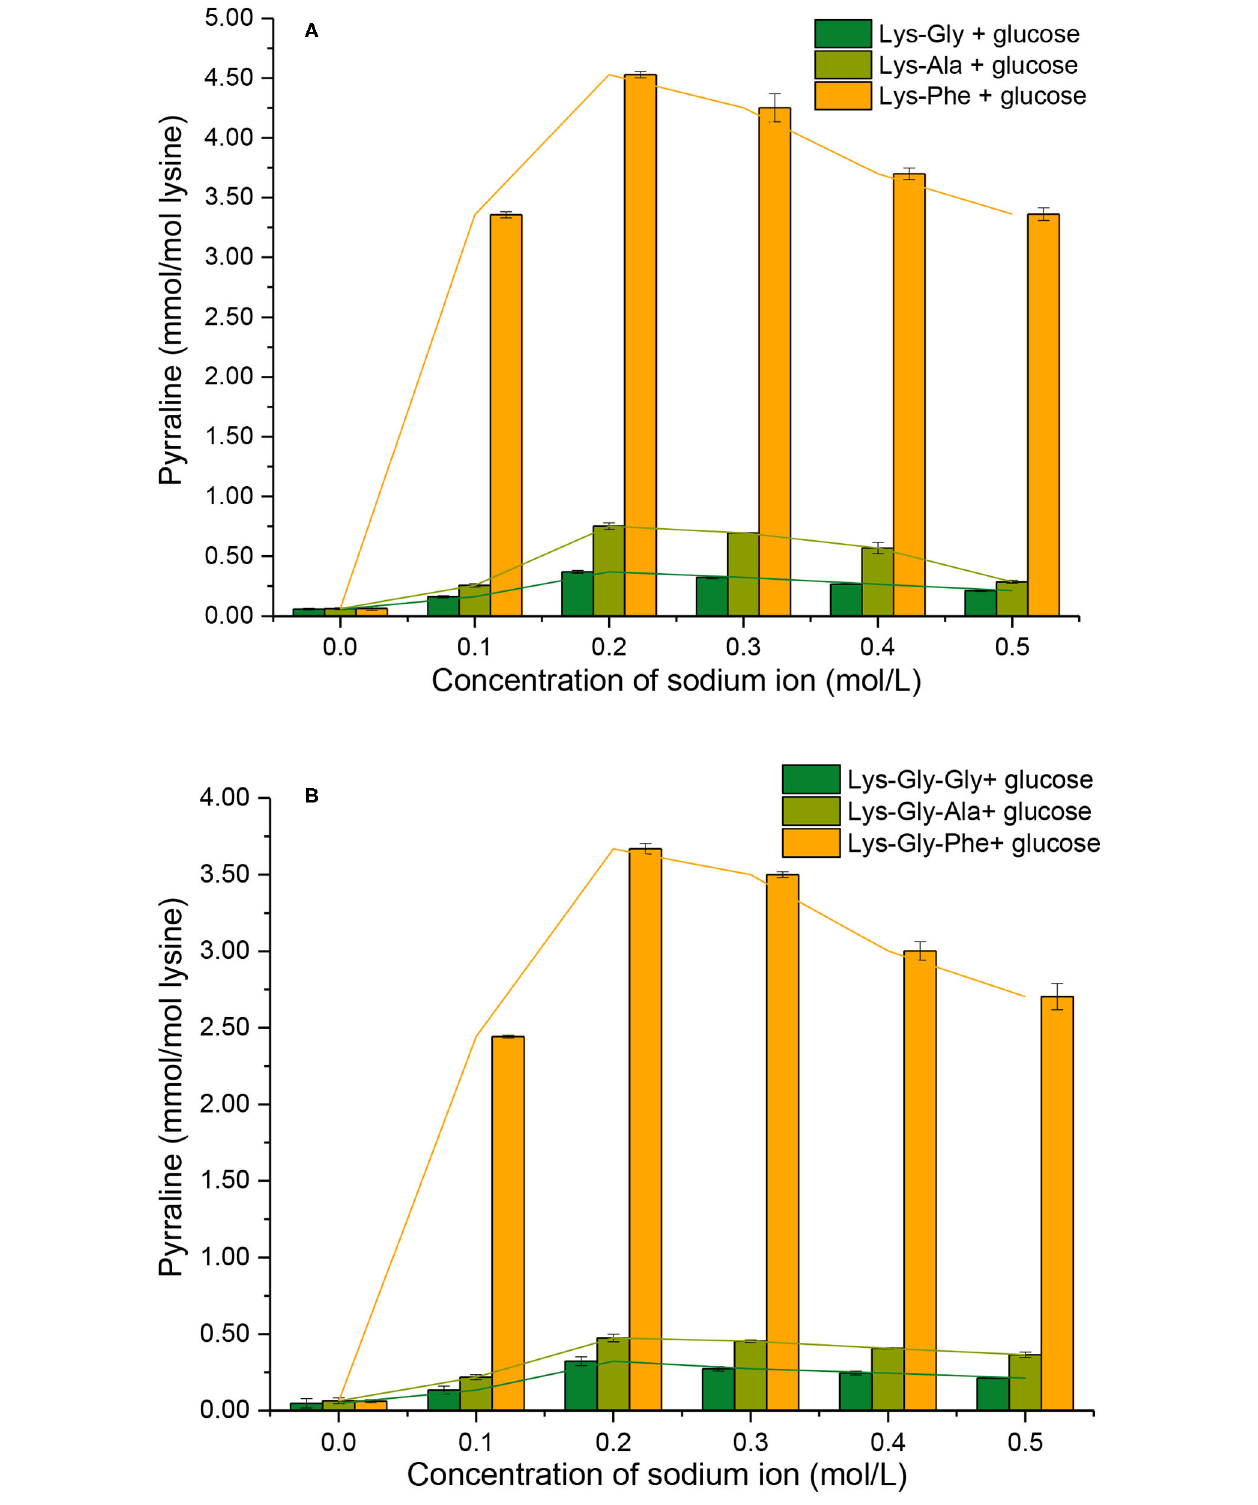
FIGURE 5 | Pyrraline formation during the Maillard reaction of peptides with glucose at different sodium ion concentrations [ (A) : in the mixtures containing dipeptides; (B) : in the mixtures containing tripeptides].